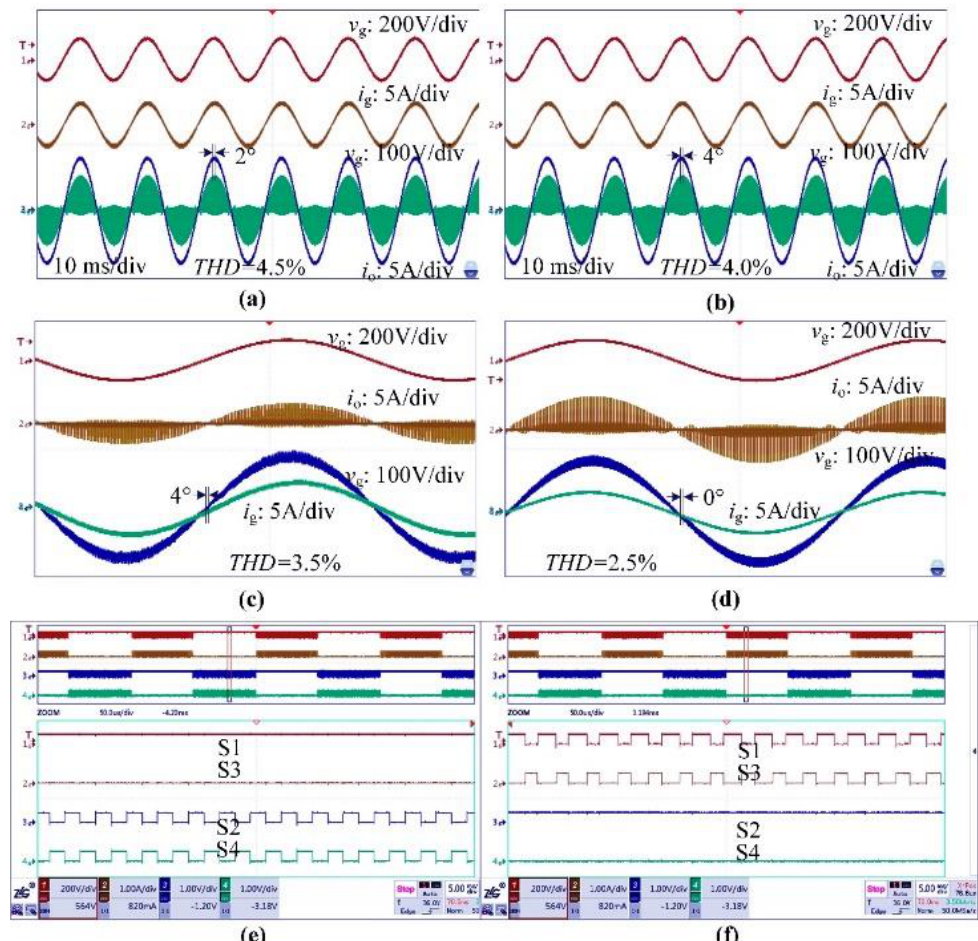
Figure 12. Comparison of open-loop and phase-compensated closed-loop control: ( a ) L = 1 mH, C = 10 µ F & open control loop; ( b ) L = 3 mH, C = 10 µ F & open control loop; ( c ) L = 3 mH, C = 10 µ F & closed control loop without phase compensation; ( d ) L = 3 mH, C = 10 µ F & closed control loop with phase compensation; ( e ) Positive half cycle drive waveform; ( f ) Negative half cycle drive waveform.